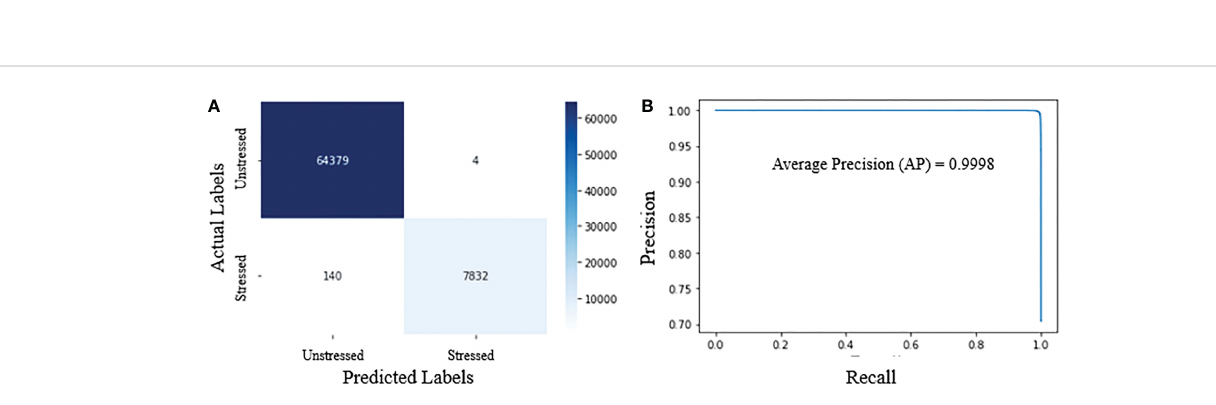
FIGURE 12 Performance metrics for HyperStressPropagateNet: (A) confusion matrix; and (B) precision-recall